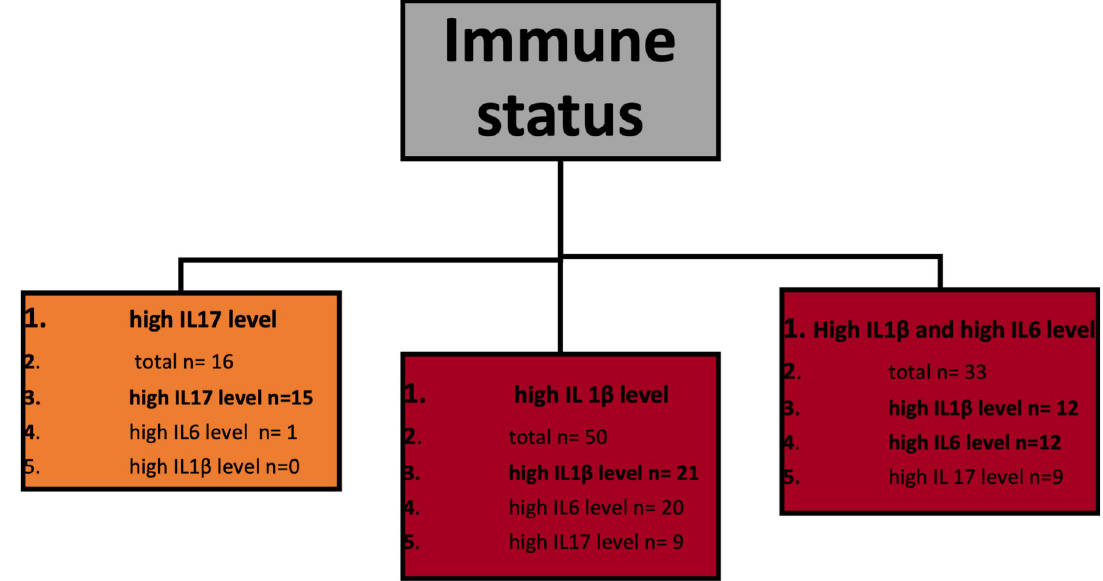
Fig 2. Classification model of high urine interleukin levels. This model classifies three separate labels: high IL17 level vs. high IL1 β level vs. high IL6 level . All three labels have been treated independently. Each of the leaves contains following information: point 1 – dominating label presented in bold, point 2- n- total number of observations classified in this leaf, points 3–5: the numbers of each observations classified in this leaf including the dominating one.